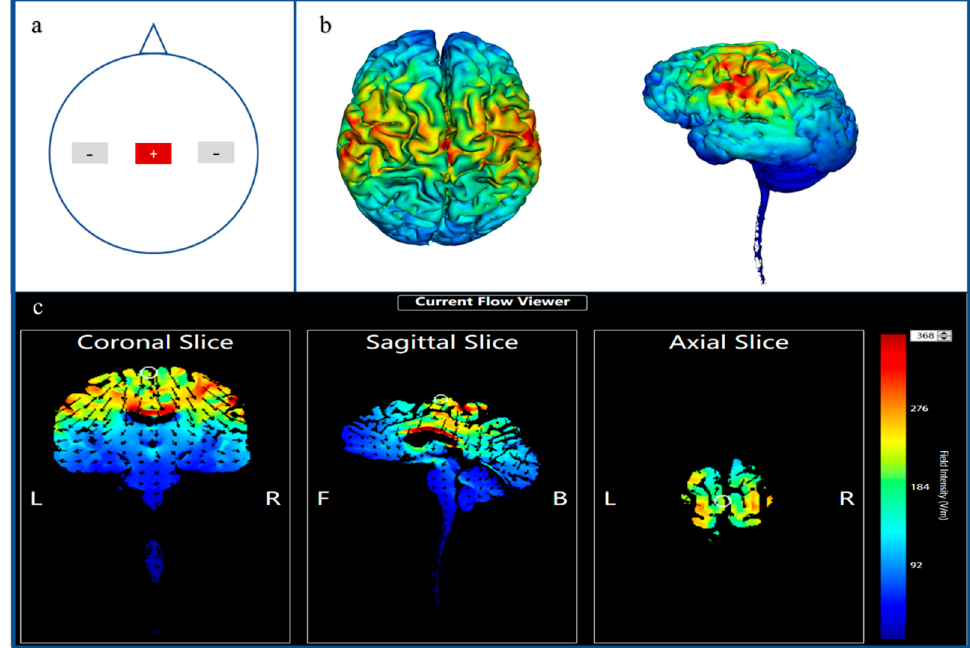
Figure 1. Overall review of transcranial direct current stimulation montages and simulation of electric field. ( a ) shows the location of the stimulated montage. The red rectangle shows the anodal stimulation area (Cz); the two gray rectangles depict the cathodal stimulation (left C5, right C6). ( b ) shows the hot point of the cerebral cortex caused by tDCS stimulation. ( c ) shows the distribution of the electric field of the tDCS at the coronal, sagittal and axial views, which were executed using the Target software.